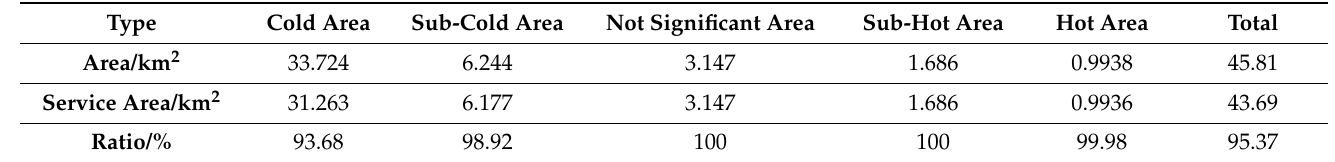
Table 6. Green Space for Disaster Prevention and Avoidance Services in Hot Living Areas.